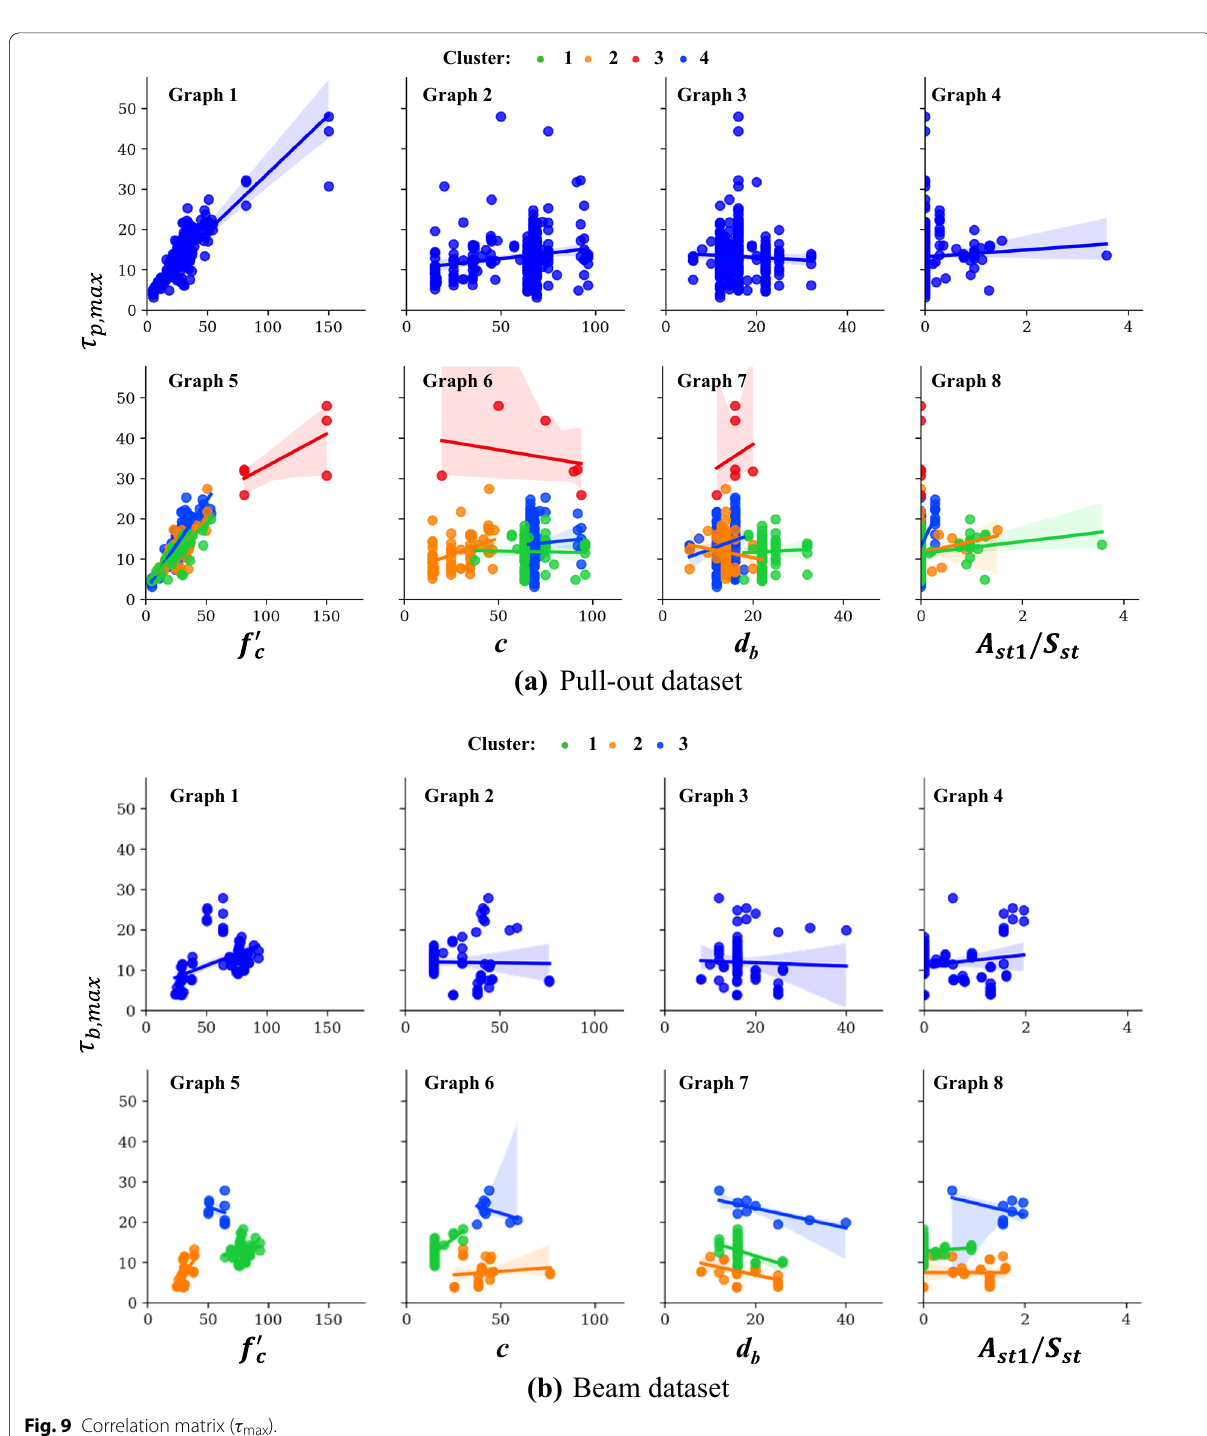
Fig. 9 Correlation matrix ( τ max